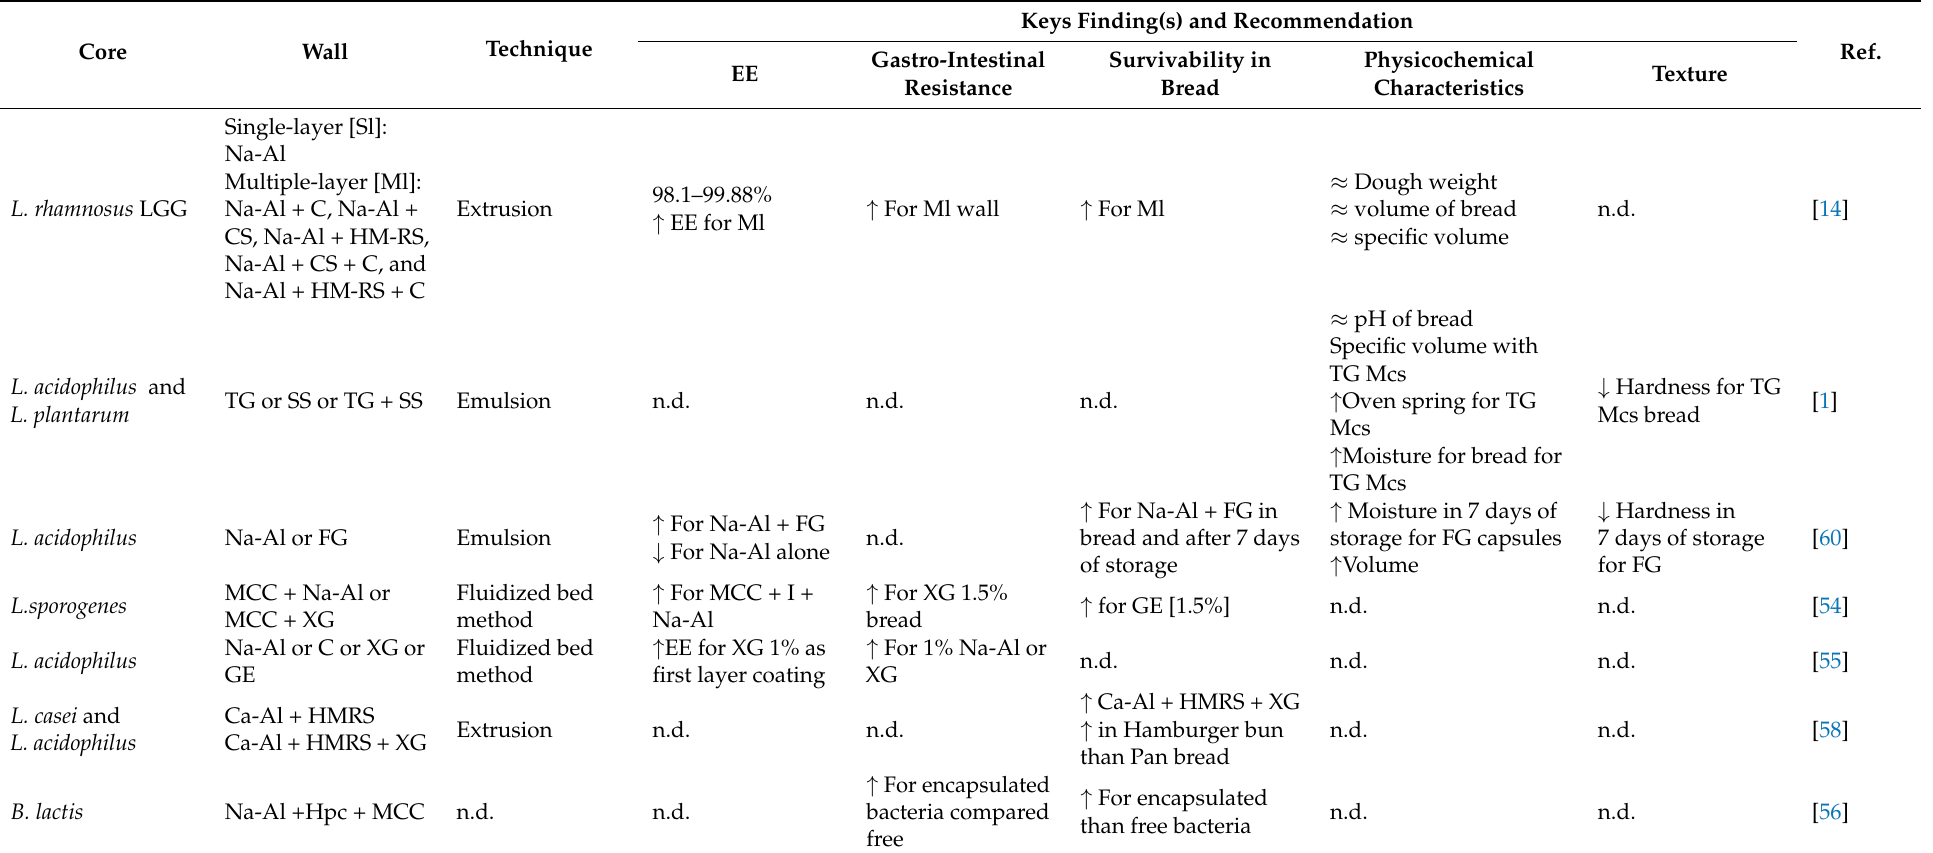
Table 5. Encapsulation of probiotics for bread